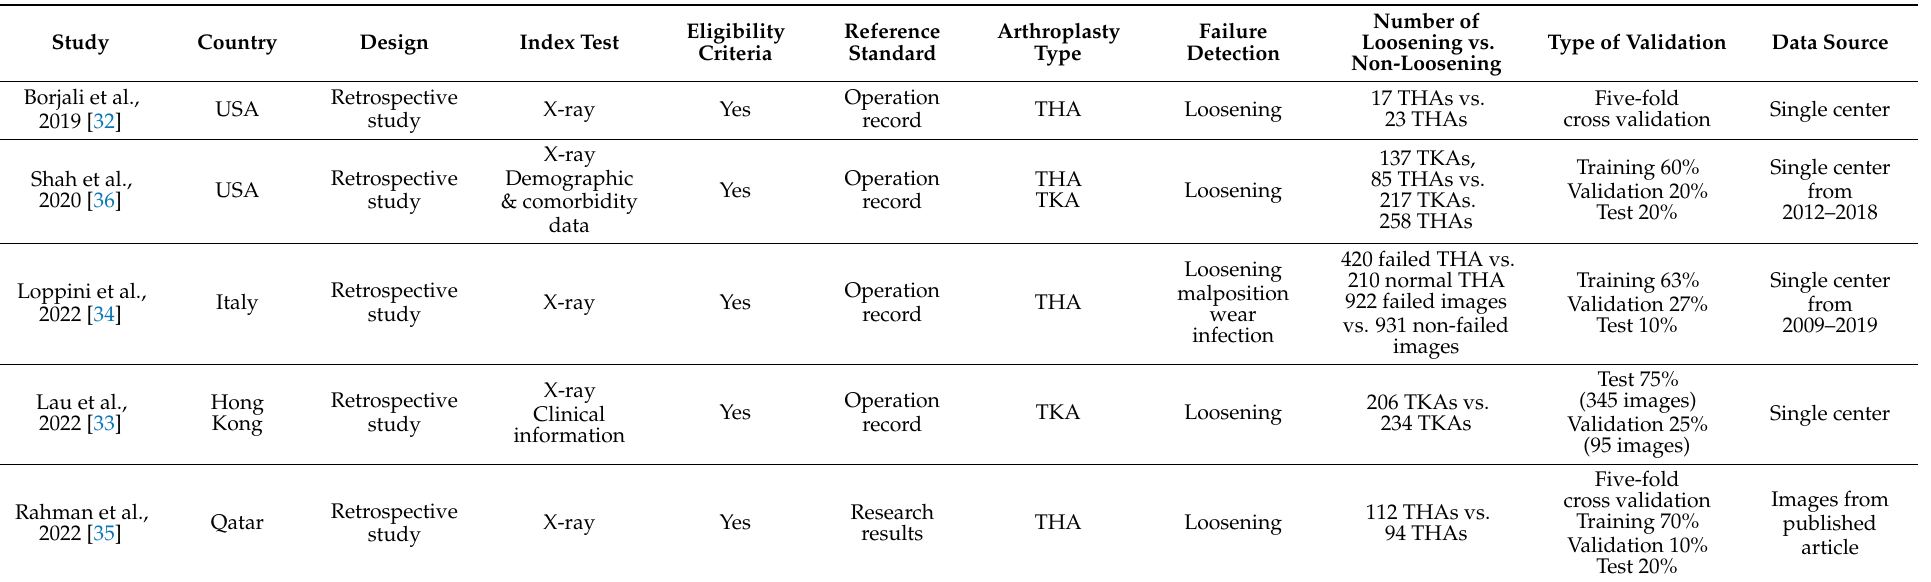
Table 1. Summary of general study characteristics.